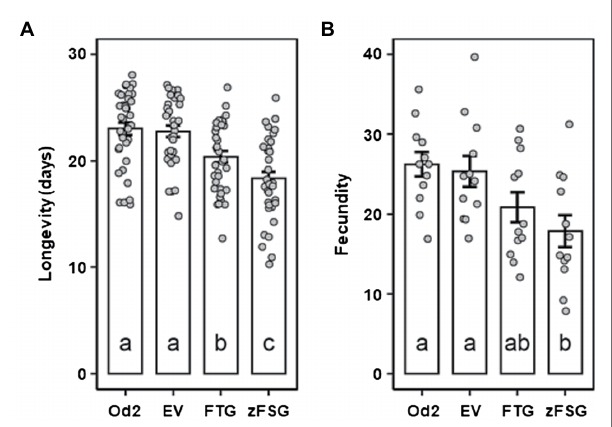
FIGURE 5 | Longevity and fecundity of potato aphids on tomato leaves expressing the multicistronic constructs. Longevity (A) and fecundity (B) of Macrosiphum euphorbiae on leaves of the odorless-2 tomato mutant (Od2), and leaves infiltrated with Agrobacterium carrying the empty pMCS vector (EV), the pC5-FTG construct, or the pC5-zFSG construct. Newly emerged aphid nymphs were arrested onto tomato leaves 2 days after Agrobacterium infiltration. Values for longevity ( n = 36) and fecundity ( n = 12) are presented as means ± SEM. Values of different leaf samples were compared by ANOVA and Tukey’s HSD test, and different letters indicate significant differences ( p <